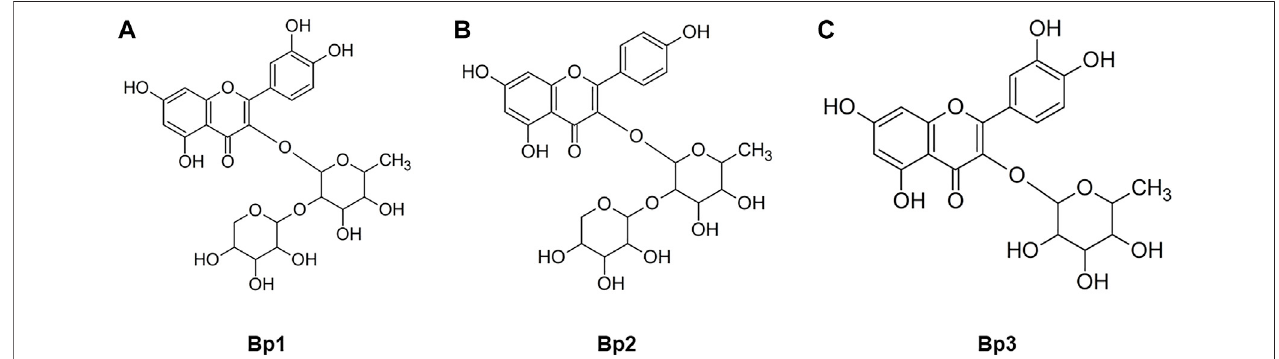
FIGURE 2 | Structures of the fl avonoids (A) quercetin 3- O - α - L -arabinopyranosyl-(1 → 2)- O - α - L -rhamnopyranoside (Bp1), (B) kaempferol 3- O - α - L - arabinopyranosyl-(1 → 2)- O - α - L -rhamnopyranoside (Bp2), and (C) quercetin 3- O - α -rhamnopyranoside (Bp3) isolated from B. pinnatum leaves.